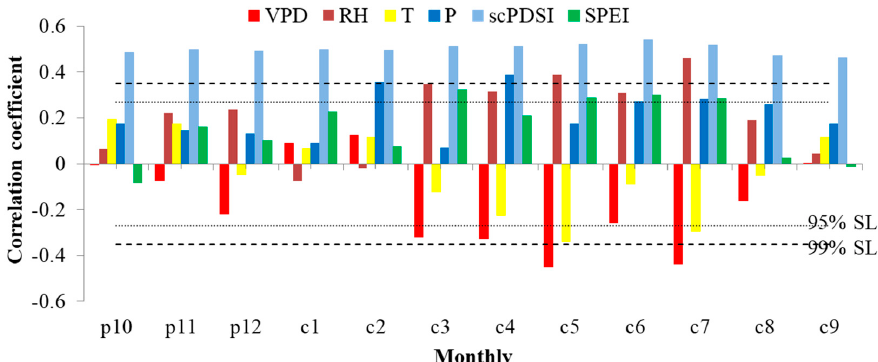
Figure 5. Correlation coefficients of tree radial growth with main meteorological factors (1960–2010). VPD, RH, T, P, scPDSI, and SPEI represent vapor pressure deficit, relative humidity, mean temperature, precipitation, self-calibrated Palmer drought severity index, and standardized precipitation-evapotranspiration index, respectively.